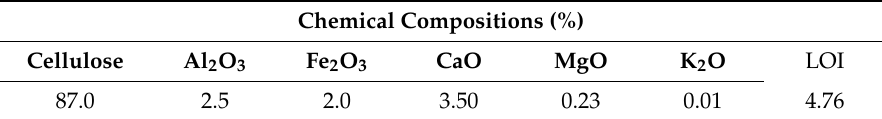
Table 1. Chemical constituents (in %) of the waste sawdust.